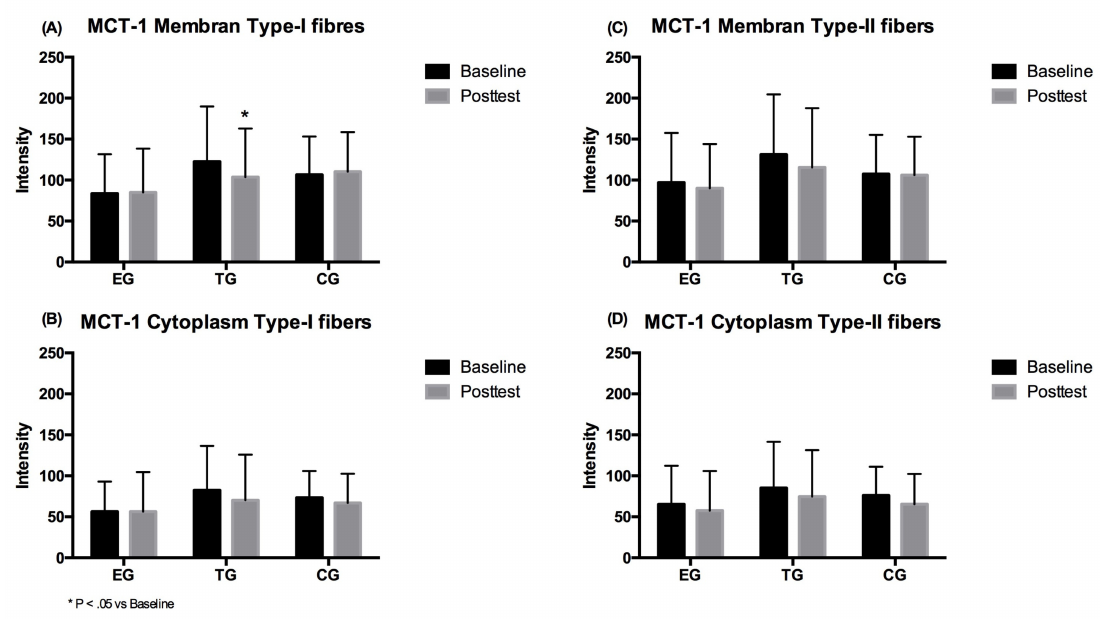
Figure 5. MCT-1 density in type-I fiber (A) membrane and (B) cytoplasm, and in type-II fiber (C) membrane and (D) cytoplasm for EMS-Group (EG), Training-Group (TG) and Control-Group (CG) measured before (Baseline) and after the 7 weeks intervention period (Posttest). Values are presented in means ±